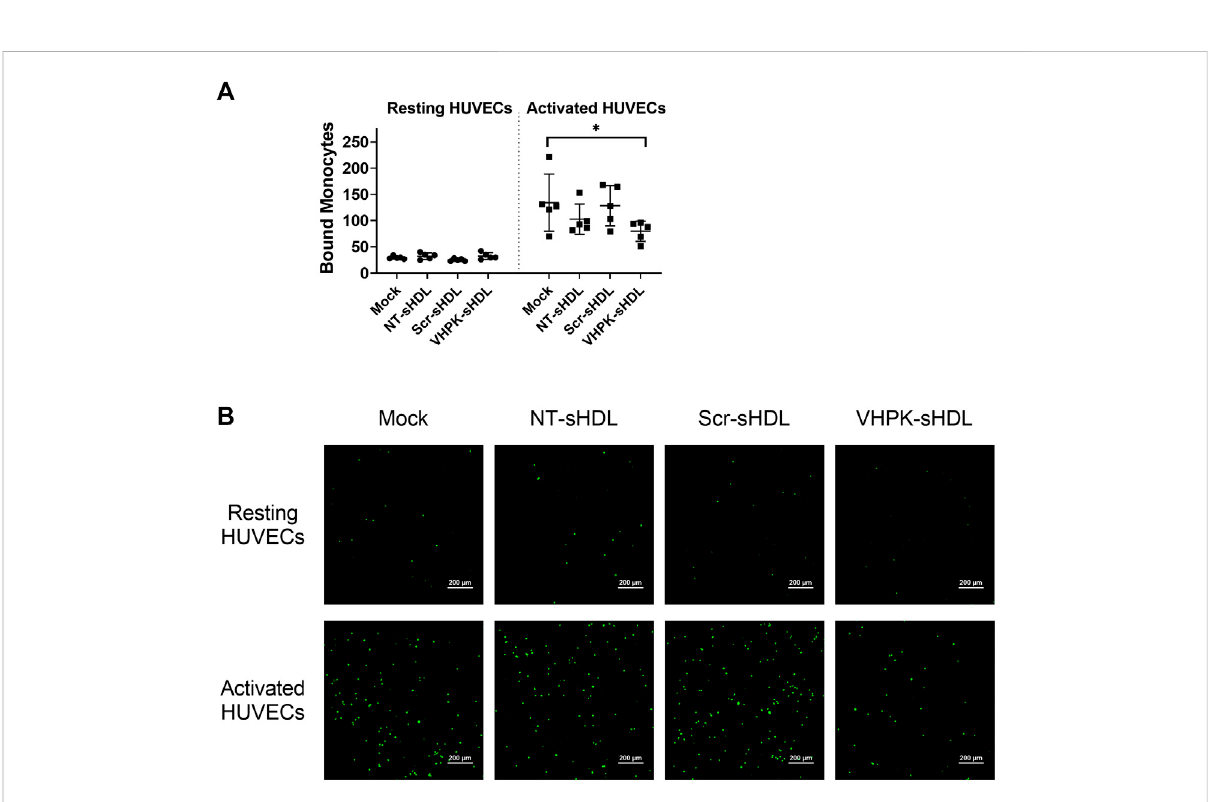
FIGURE 6 (A) Quanti fi cation of bound THP-1 monocytes on resting and activated HUVEC monolayers ( n = 5, mean ± SD, * p < 0.05). (B) Representative images of fl uorescently labeled THP-1 monocytes adhered on HUVEC